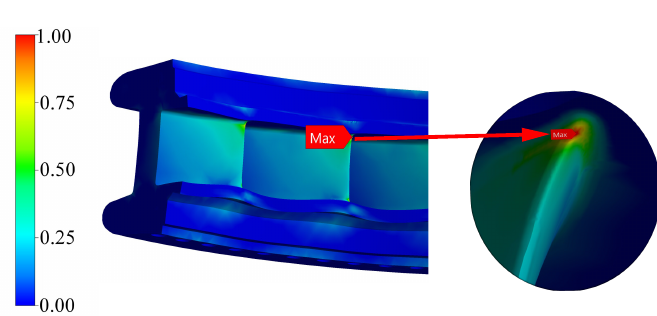
Figure 17. The maximum stress of the stay ring during turbine start-up.